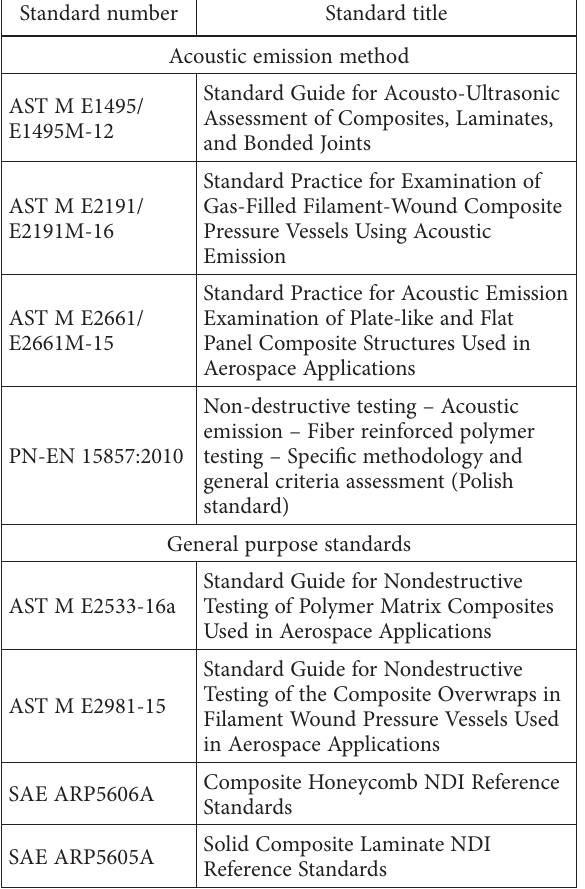
Table 1. List of standards for testing of composites by the method of acoustic emission and general purpose